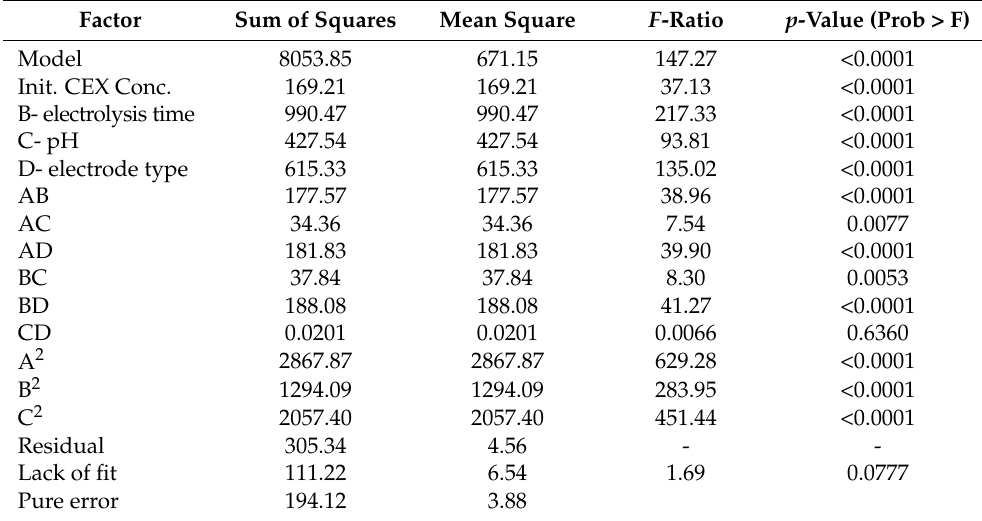
Table 3. Analysis of Variance (ANOVA) for the RSM Model of the percentage of CEX Removal. Factor Sum of Squares Mean Square F